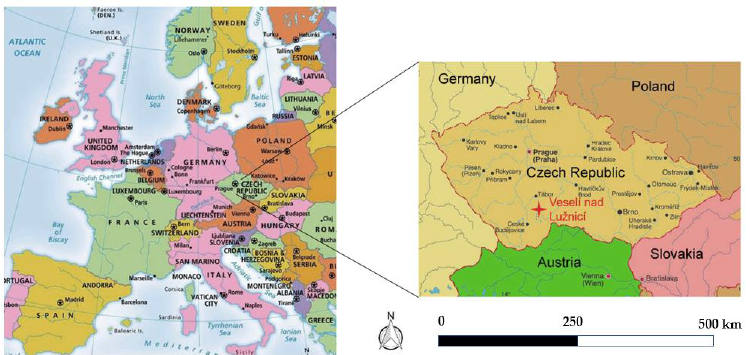
Figure 9. Location of the well S-V near Veselí/n. Lužnicí.